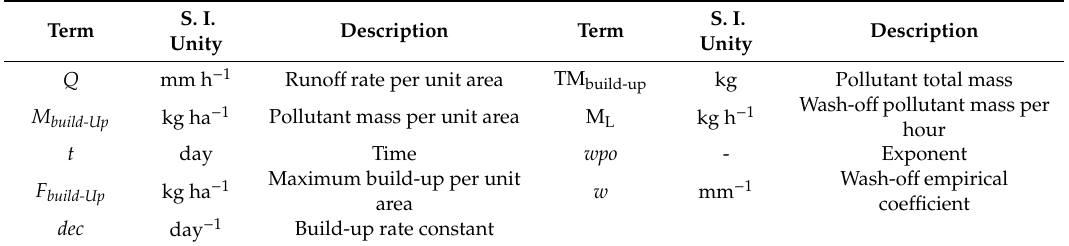
Table 2. Terms of the runo ff water quality model equations